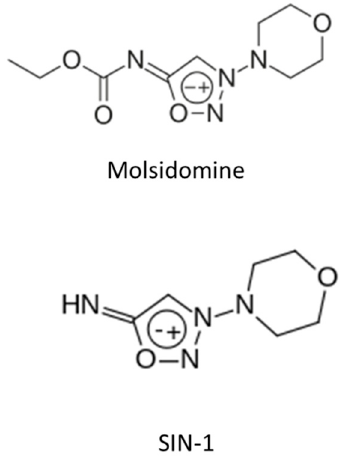
Figure 4. Molsidomine and SIN-1.